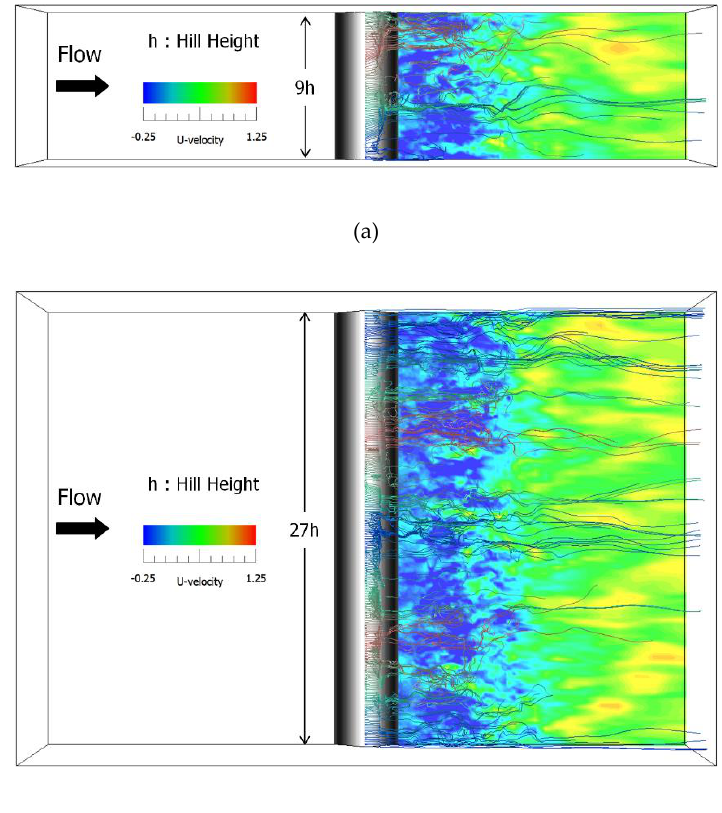
Figure 7. Comparison of nondimensional streamwise standard deviation profiles in the wind tunnel experiment and numerical simulation. Numerical flow visualization shows the flow field with time averaging and spatial averaging in the spanwise direction. (a) x = 0h, (b) x = 1h, (c) x = 2h, (d) x =